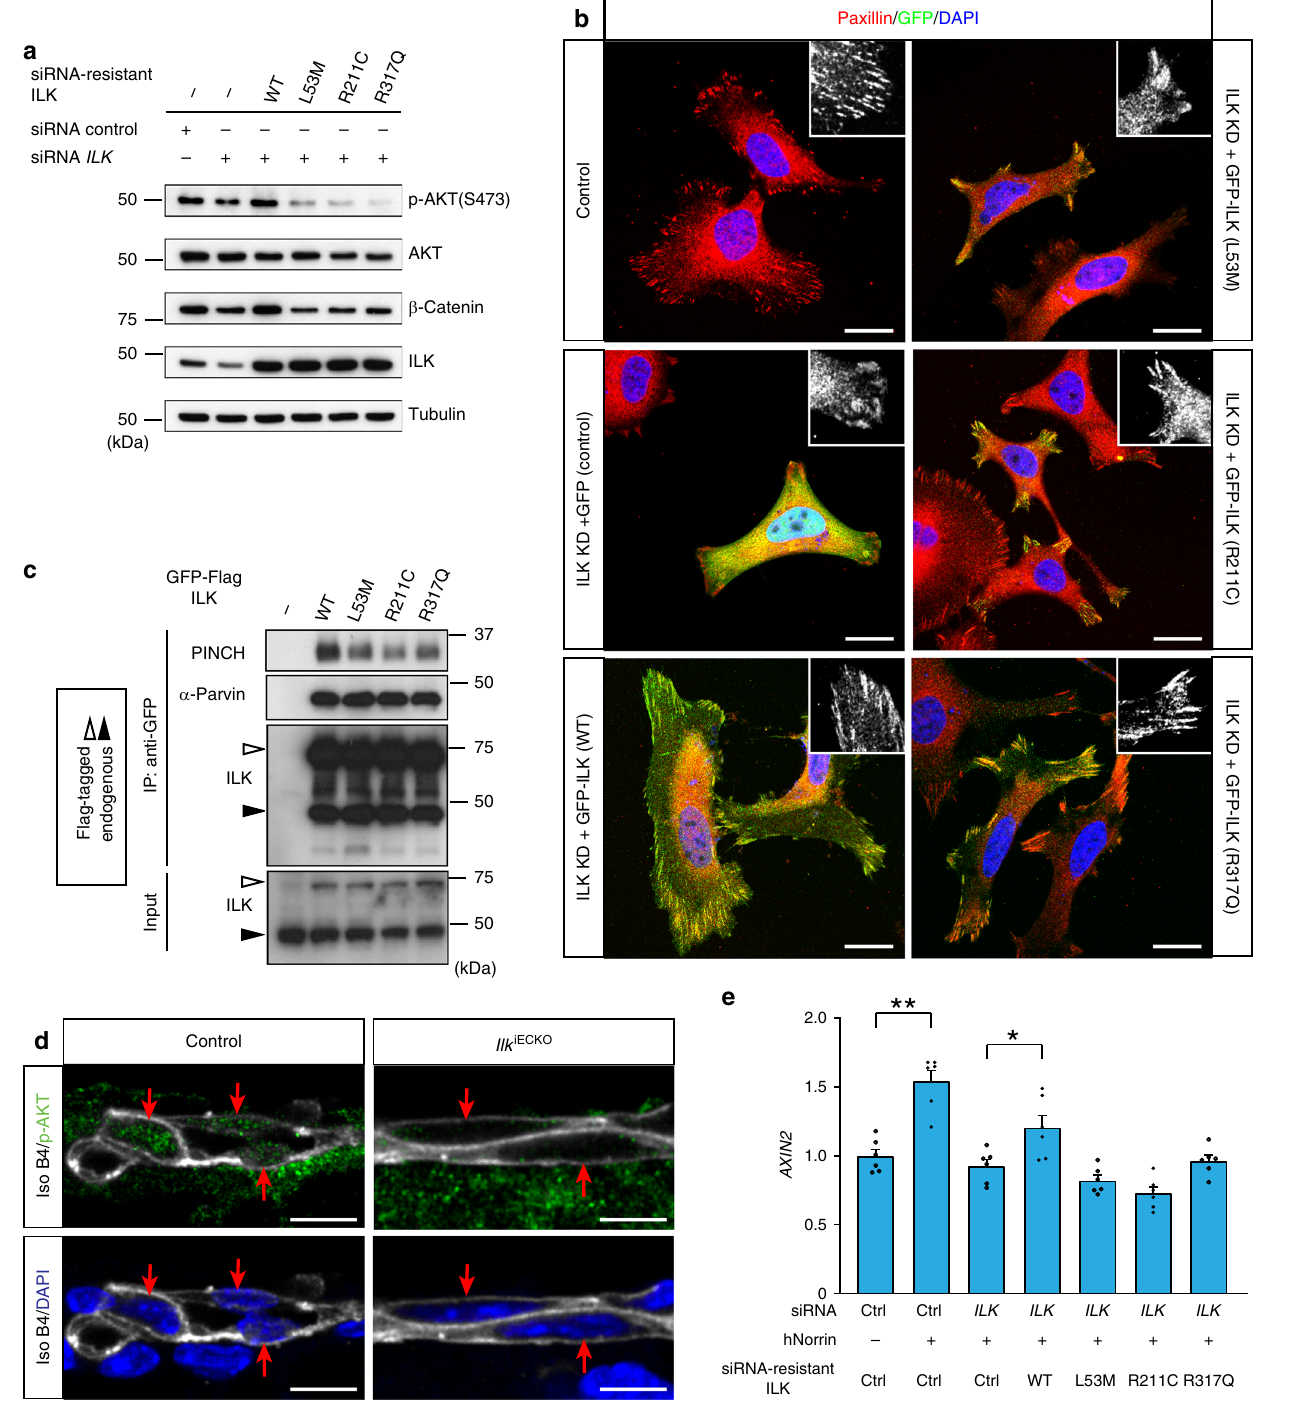
Fig. 7 Functional consequences of ILK mutant alleles. a Western blot analysis of β -catenin and AKT Ser473 phosphorylation in HUVEC after siRNA- mediated knockdown of endogenous ILK and expression of siRNA-resistant wild-type (WT) ILK and variant versions, as indicated. Quantitation provided in Supplementary Fig. 5A. b Paxillin (red) and DAPI (nuclei, blue) stained HUVECs showing the changes in cell morphology and focal adhesion formation (high-magni fi cation insets) after knockdown (KD) of endogenous ILK expression and transfection with either GFP alone (GFP), a GFP fusion with wild-type (WT) ILK, or GFP fusions with L53M, R211C, and R317Q ILK. ILK KD-induced cell spreading and focal adhesion defects are reverted by expression of WT GFP-ILK but none of the three mutant constructs. Scale bar, 20 μ m. c Immunoprecipitation (IP) and Western blot analysis of wild-type (WT) or mutant GFP-ILK and associated PINCH and α -parvin proteins. White arrows indicate GFP-ILK and black arrows endogenous ILK. d Confocal images of p-AKT (Ser473) (green) and isolectin B4 (white) staining in control and Ilk iECKO P6 retina sections. Presence (control) or absence ( Ilk iECKO ) of p-AKT in endothelial nuclei (red arrows) in images with or without DAPI signal (blue). Scale bar, 10 μ m. e qPCR analysis of AXIN2 expression in HUVEC after siRNA knockdown of endogenous ILK and expression of siRNA-resistant wild-type (WT) or variant ILK proteins, as indicated. Error bars, s.e.m. p values (** p < 0.01, * p < 0.05, ns not signi fi cant), Student ’ s t test ( n = 6). Source data are provided as a Source Data fi